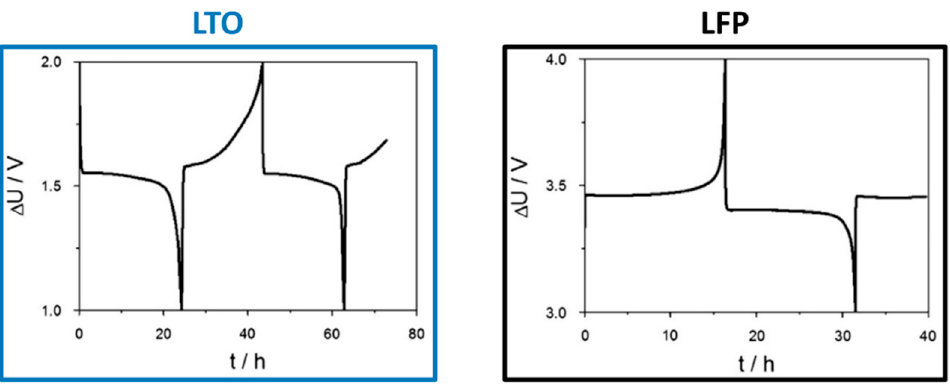
Figure 15. Charge/discharge profile of Li 4 Ti 5 O 12 ( left ) and LiFePO 4 ( right ) vs. Li + /Li during RE preparation. Figure adapted with permission from [15].